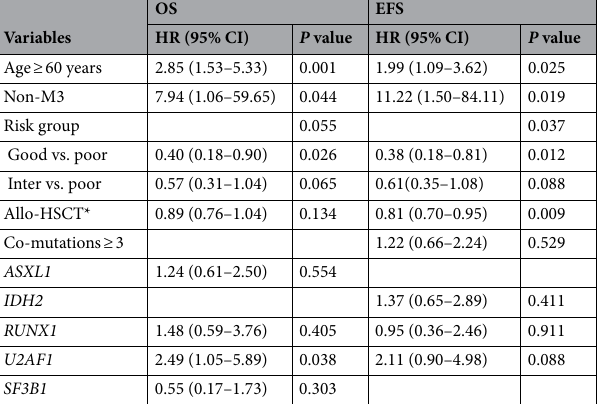
Table 4. Multivariate analysis for OS and EFS in NRAS mut AML. HR Hazard ratio, allo-HSCT allogenic hematopoietic stem cell transplantation, allo-HSCT * the time-dependent variable for allo-HSCT (allo- HSCT ×